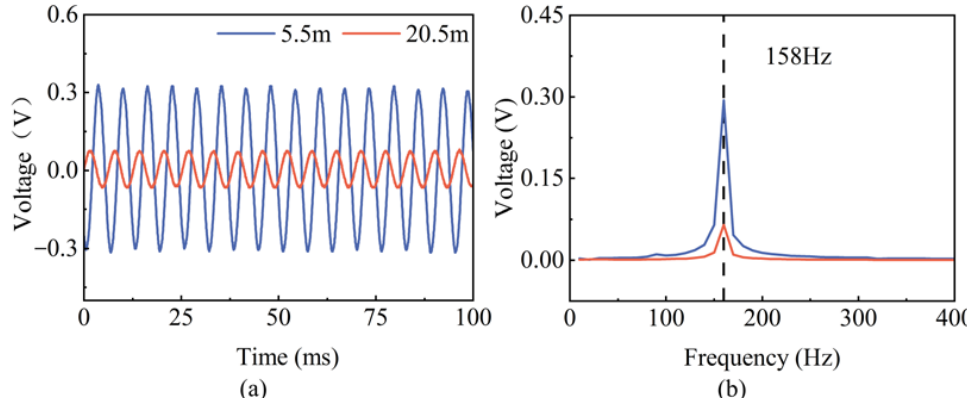
8 of 14 Figure 6. Details of the test pipeline system: ( a ) schematic diagram of the test pipeline system, ( b ) real picture of the test pipeline system. 3.2. The Characteristics of Pipeline Acoustics Without imposing high water pressure, an underwater loudspeaker is placed at the location of the pipeline leak to simulate a sound source with a fixed frequency of 158 Hz. T he signal generated by the underwater loudspeaker is received by the MEMS hydro- phones at both ends. The time domain plot and frequency domain plot of the 158 Hz acoustic signal collected by the two MEMS hydrophones are shown in Figure 7. As can be